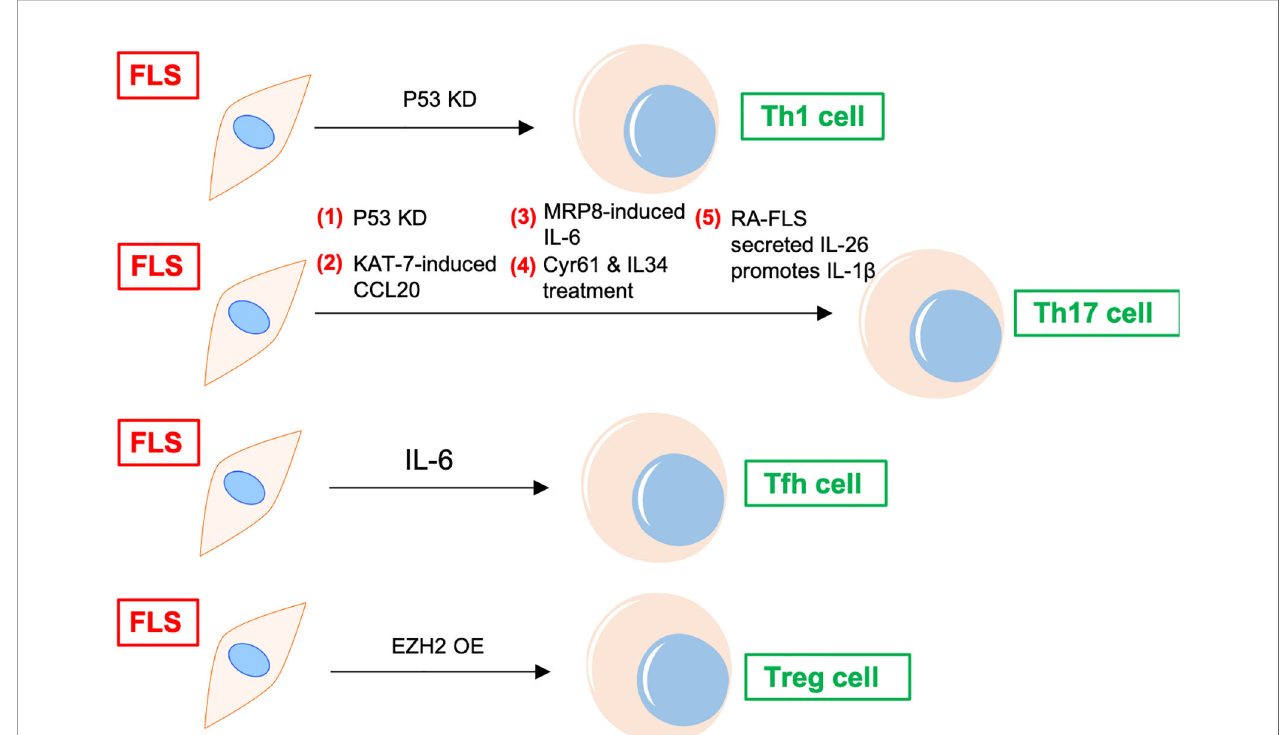
FIGURE 2 | FLS regulates differentiation of CD4 + T cells in RA. P53 KD and EZH2 OE promote Th1 and Treg differentiation of T cells in RA synovium, respectively. FLS promotes Tfh differentiation of T cells via IL-6. FLS directly induces Th17 differentiation through cytokines, including CCL20, MRP8, IL-6, and IL-26, etc. KD, knockdown; OE, overexpression; Tfh, T follicular helper; CCL, C – C motif chemokine ligand; MRP, myeloid-related protein; TLR, Toll-like receptor; Cyr61, cysteine- rich protein 61; EZH, enhancer of zeste homolog; Treg, regulatory T